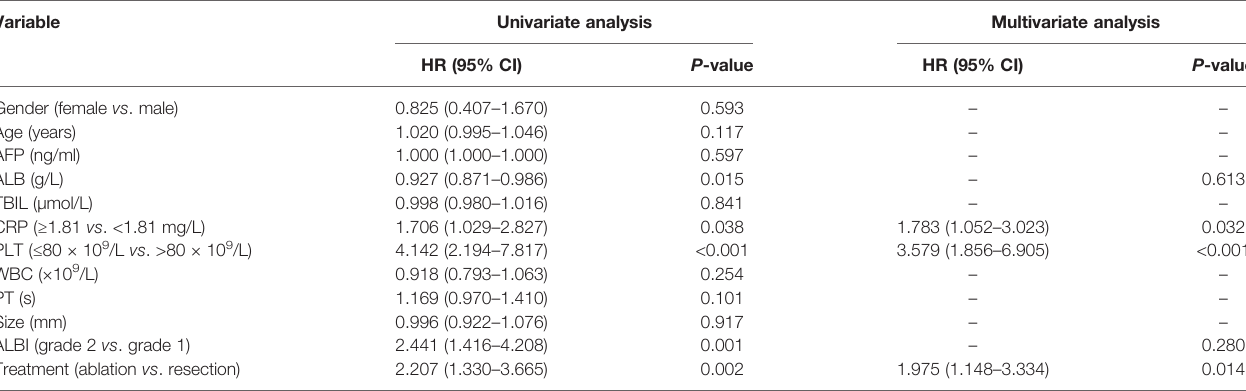
TABLE 5 | Univariate and multivariate analyses of the occurrence of HRBM in the entire cohort. Variable